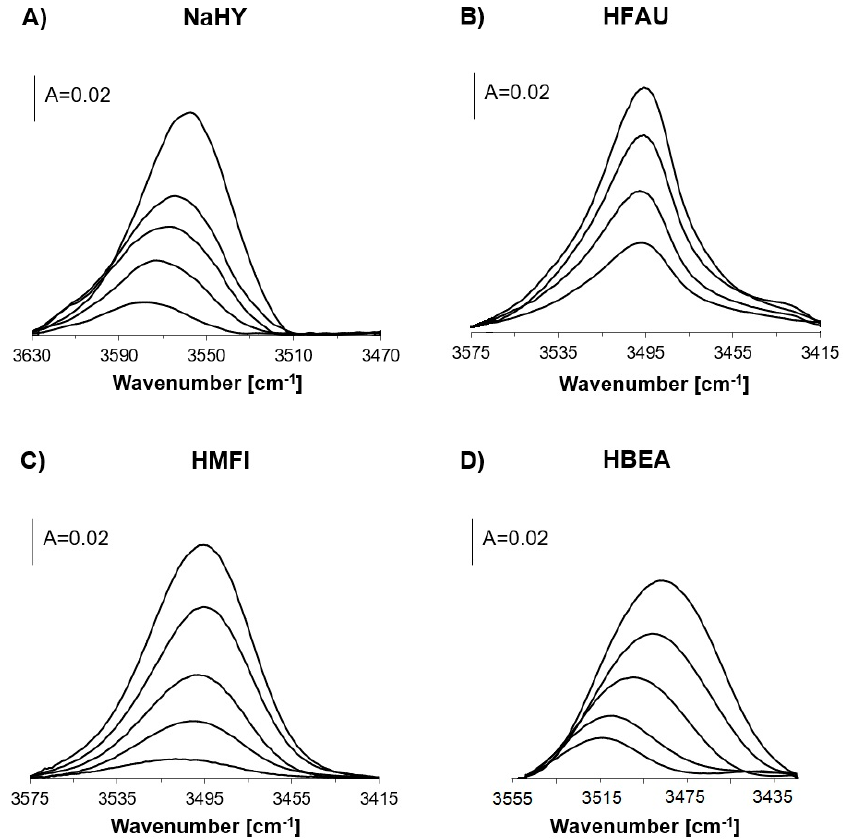
Figure 3. The IR spectra of Si–OH–Al groups in zeolites NaHY ( A ), HFAU ( B ), HMFI ( C ), and HBAE ( D ) interacting with nitrogen at 170 K. Top spectra were recorded upon nitrogen sorption in zeolites without ammonia. All other spectra were recorded upon nitrogen sorption in which ammonia was sorbed and subsequently desorpbed at increasing temperatures. Desorption temperatures from bottom to top: NaHY 418, 433, 443, 458 K; HFAU 473, 483, 505 K; HMFI 473, 483, 503, 518 K; and HBEA 443, 463, 483, and 503 K.